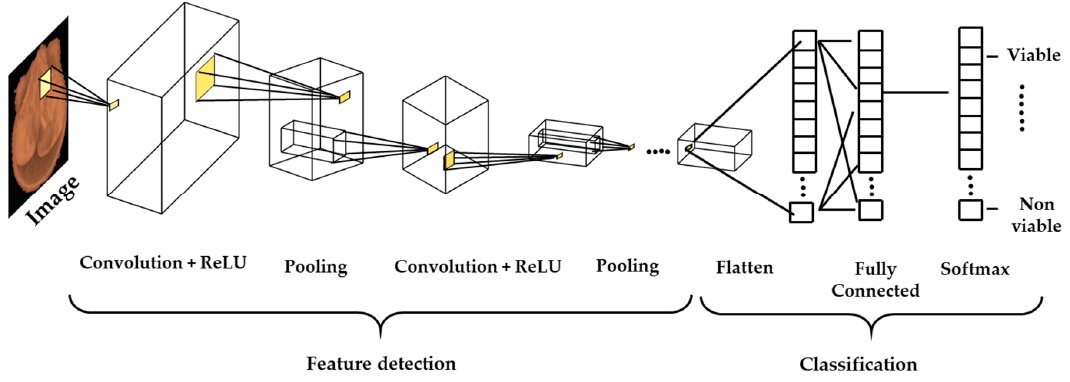
Figure 3. A ConvNets sequence to classify seeds into 2 classes.